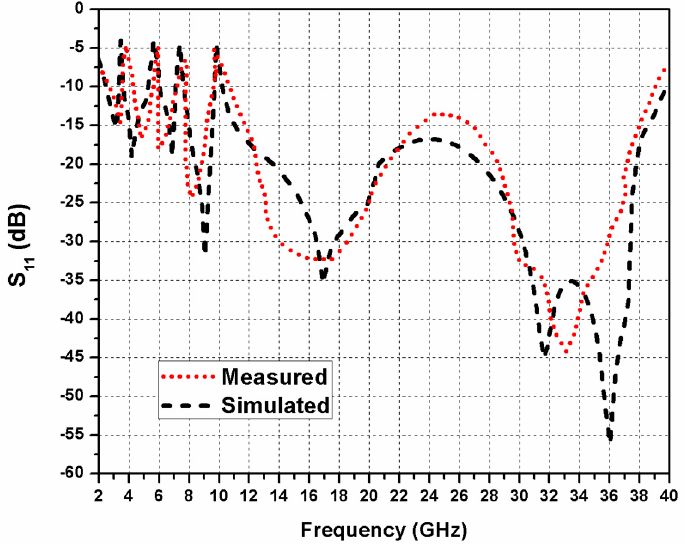
Figure 8. Reflection coefficients of the proposed quad band-notched SWB antenna.